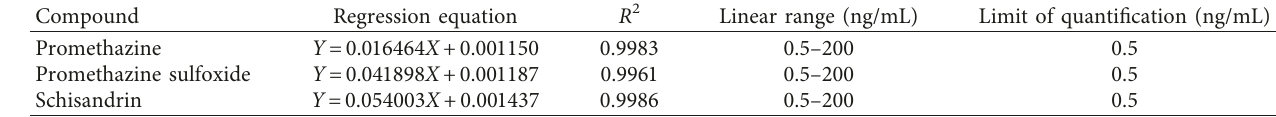
Table 2: Regression equations, linear ranges, and LLOQs of the three compounds.